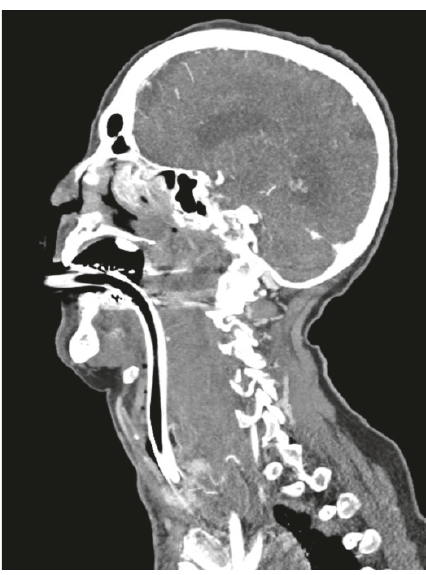
Figure 1: Sagittal plane CT angiogram of neck following intubation demonstrating a large retropharyngeal hematoma and anterior airway